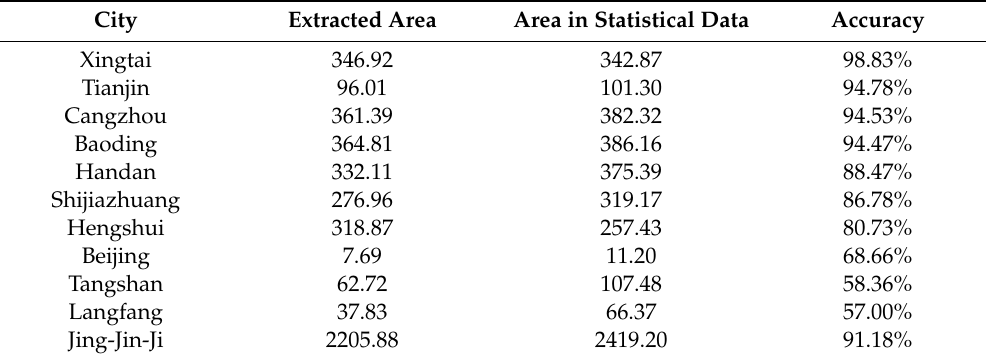
Table 5. Cultivar coefficient localization results of the DSSAT-CERES-Wheat model. Parameter